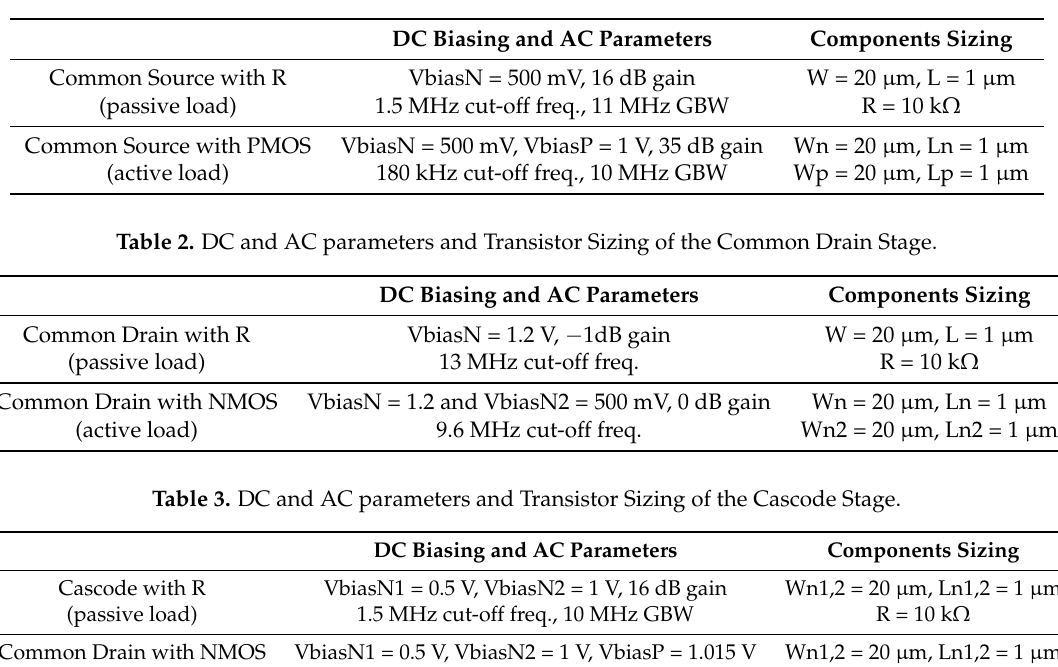
Table 1. DC and AC parameters and Transistor Sizing of the Common Source Stage.